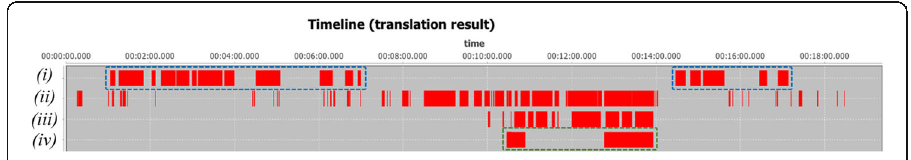
Fig. 8 Result examples of applied higher-level interpretation